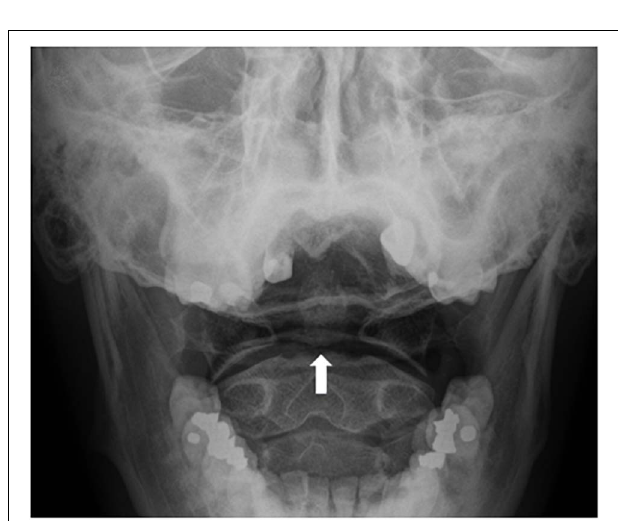
FIGURE 2 | Mach bands across the base of the dens (a bone that projects from the spinal vertebra, also known as the “odontoid process”), can be mistaken for fractures (white